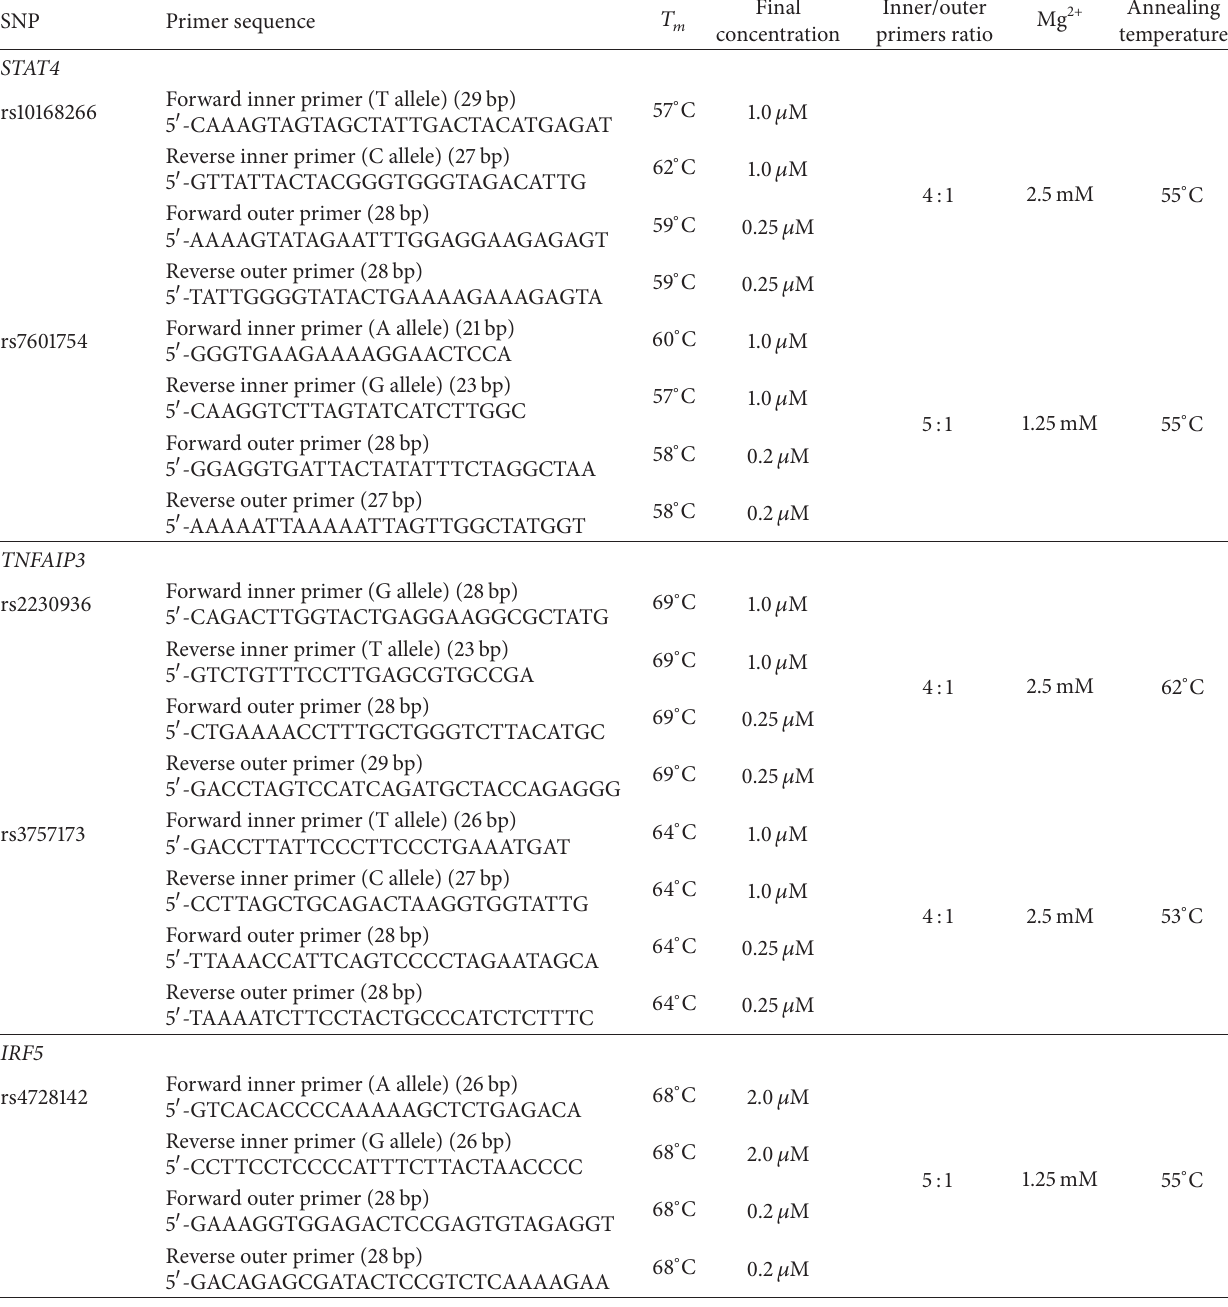
Table 3: Touchdown PCR primers and